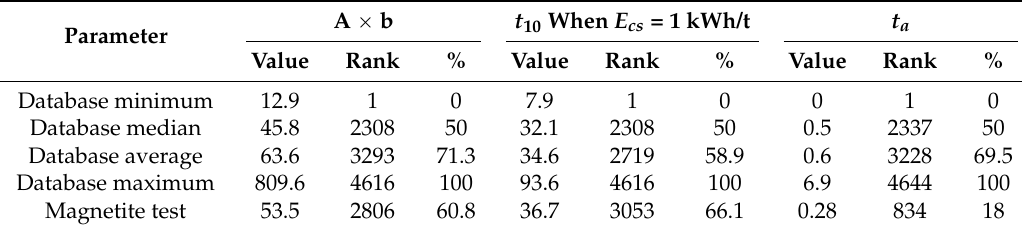
Table 1. Comparison between the Eastern Hebei magnetite ore and JKTech ore characteristic database.